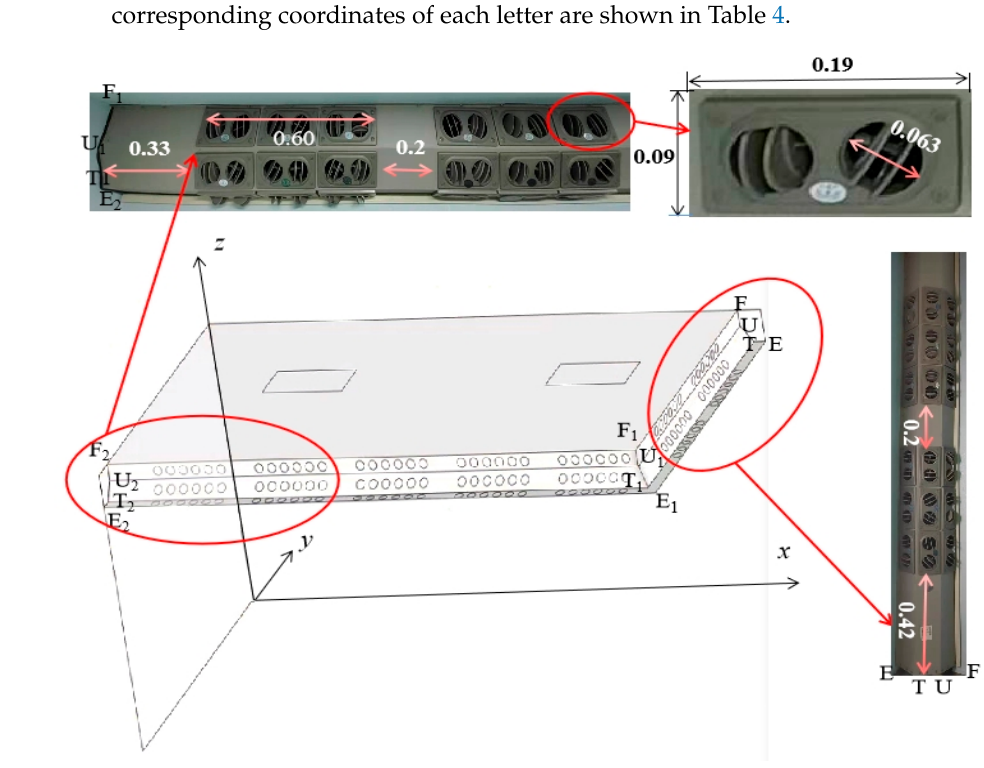
Figure 3. The corresponding letters of the display and control console. Table 3. T he corresponding coordinates of each letter in the display and control console.